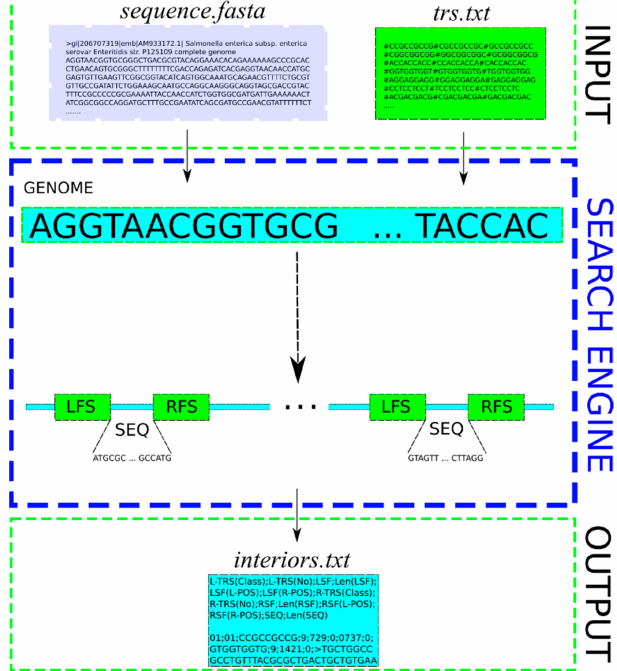
Figure 2. Schematic diagram of the functioning of the engine of TRS-omix. The input data that contain nucleotide sequences in the genome (called sequence.fasta ) are analyzed for the presence of TRS motifs, and the TRS-omix search engine produces a file (called interiors.txt ) containing useful information for further genome analysis. Labeling: LFS—means the left flanking sequence (at least triple repetition of the same TRS from the 5 (cid:48) direction), RFS—means the right flanking sequence (at least triple repetition of the same TRS from the 3 (cid:48) direction), SEQ—means an extracted DNA sequence (see at https://github.com/TRS-omix/software, accessed on 21 February 2023).